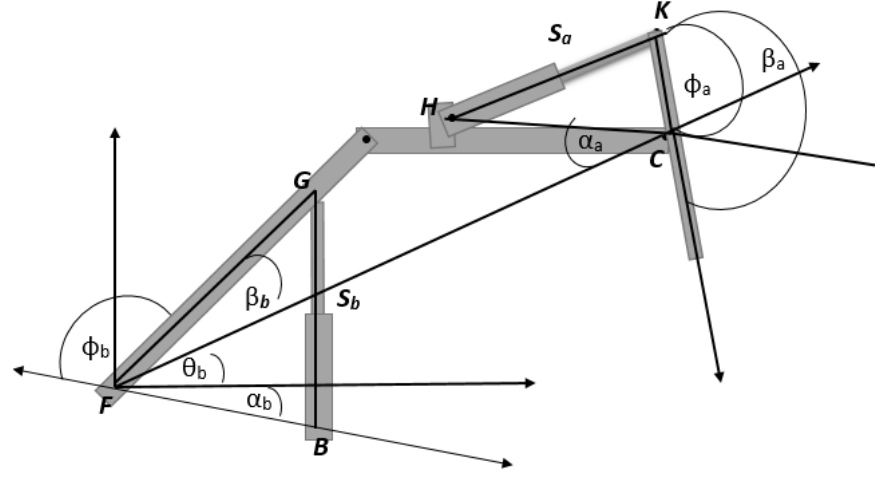
Figure 4. Joint angles and links for the excavator.